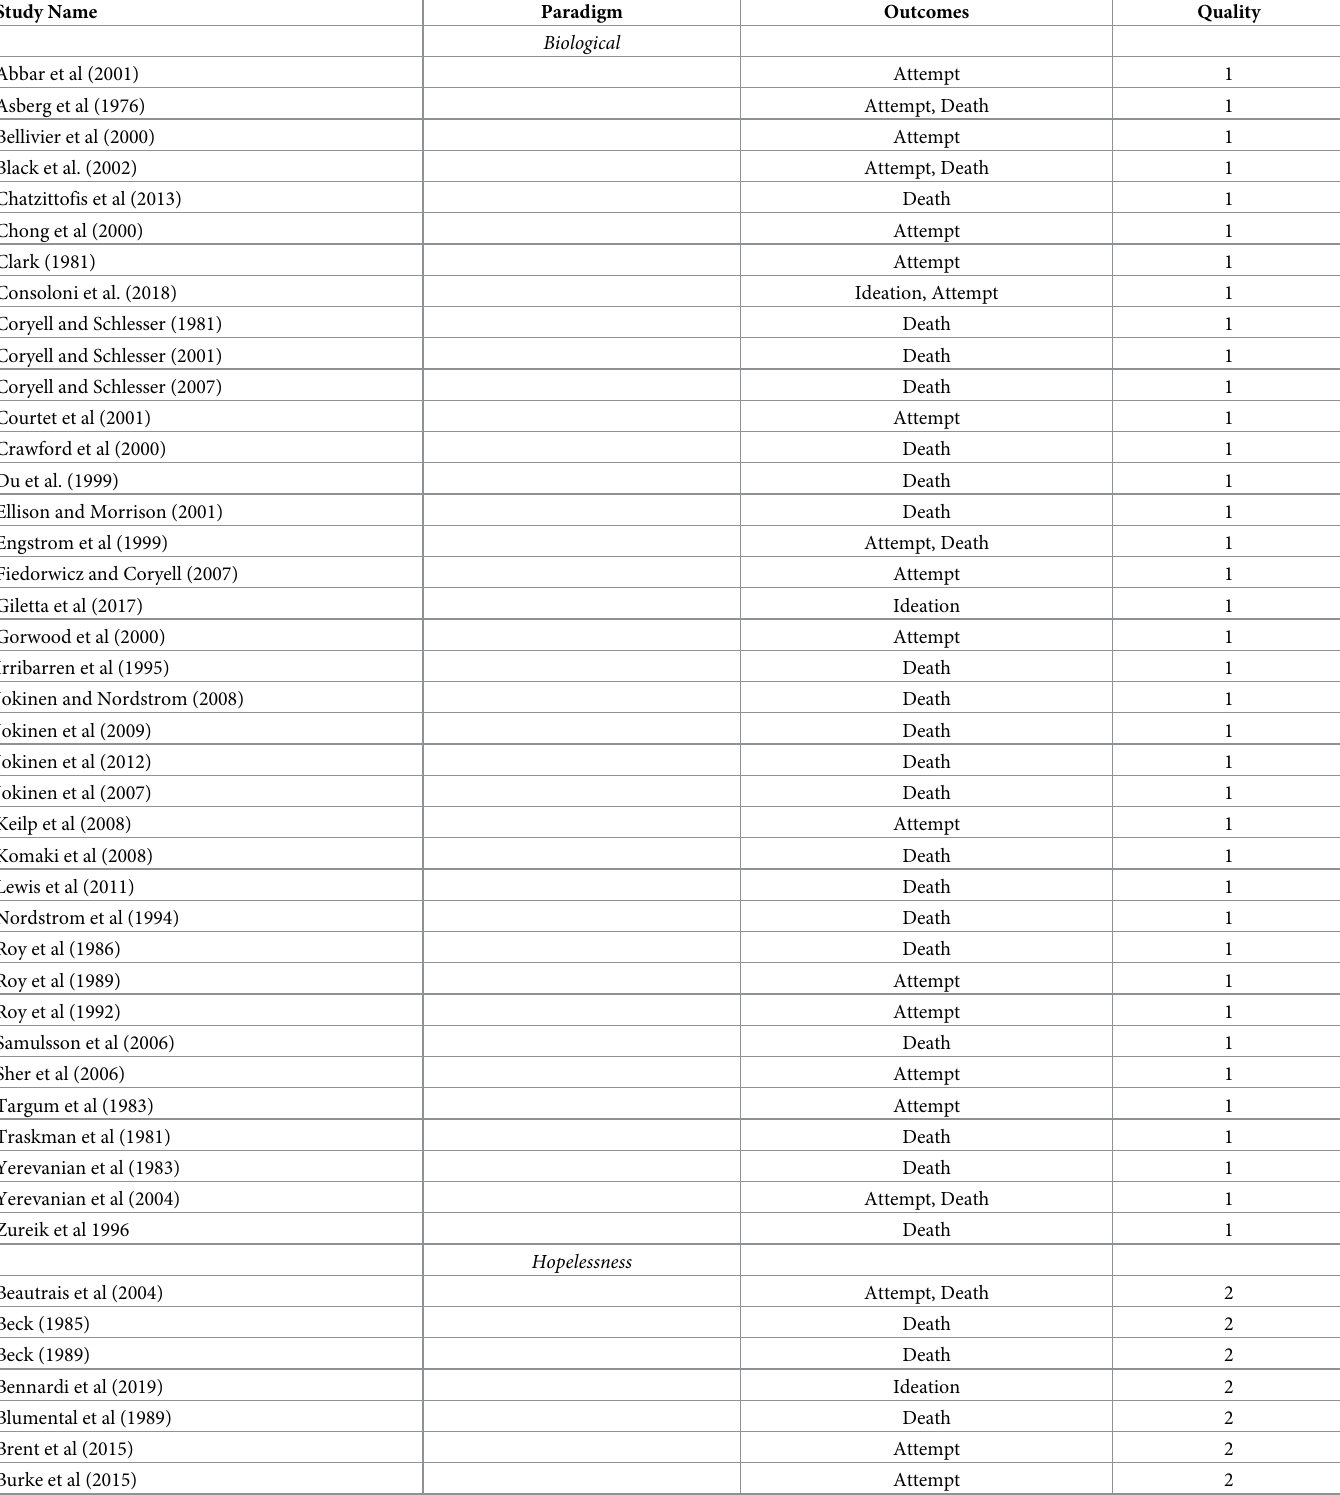
Table 1. List of studies by paradigm and